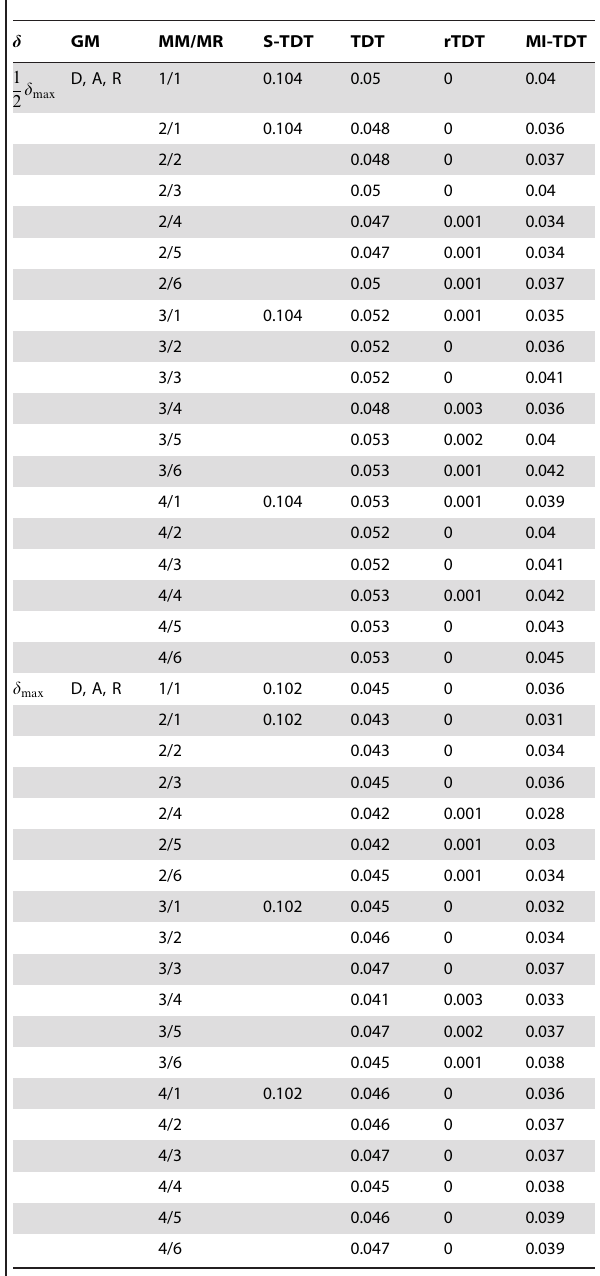
Table 10. Power values at 1% significance level when alternative hypothesis is h ~ 0